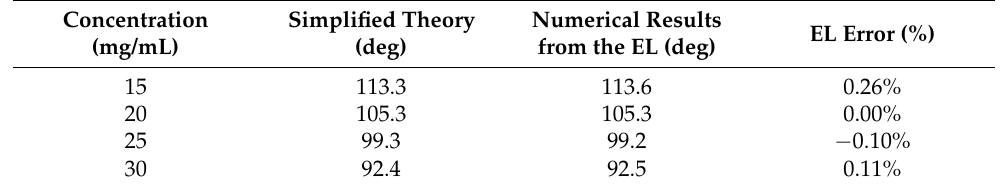
Table 3. Comparison of theoretical and numerically obtained values for orientation angles at align- ment.